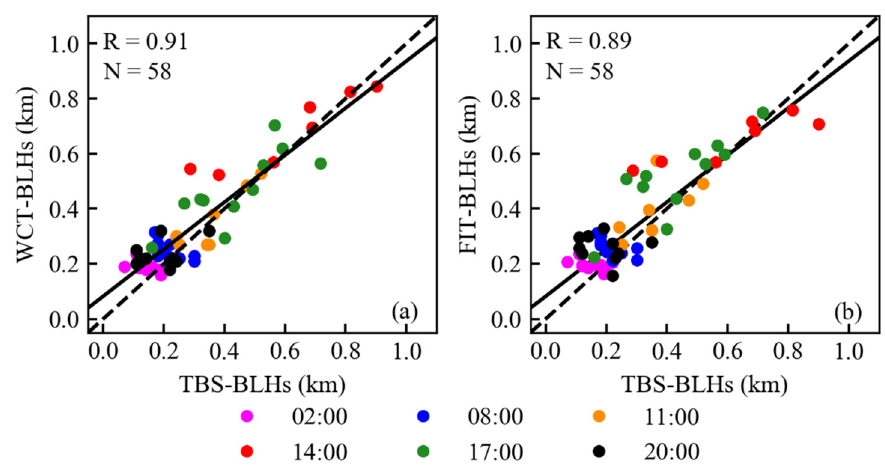
Figure 8. Scatter plot of TBS-BLHs and WCT-BLHs ( a ) and TBS-BLHs and FIT-BLHs ( b ).